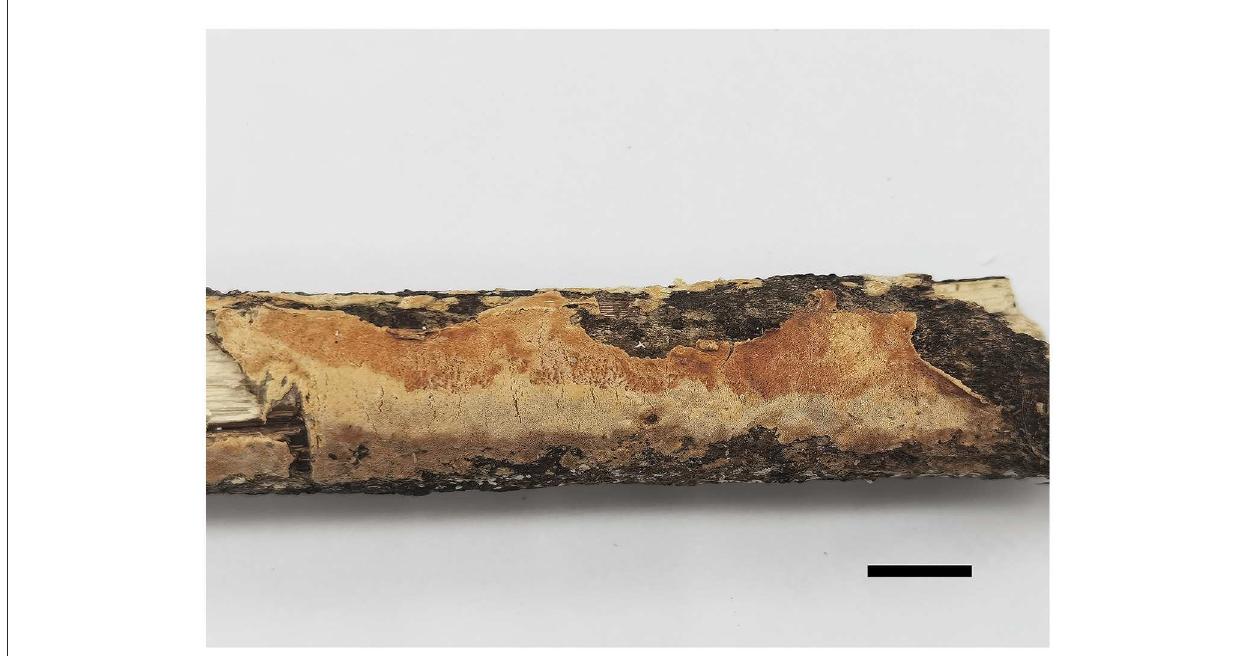
FIGURE2 Basidiomata of Steccherinum incrustans (Holotype, Dai 19442). (Scale bar = 1.0cm). Photographed by Meng Zhou.